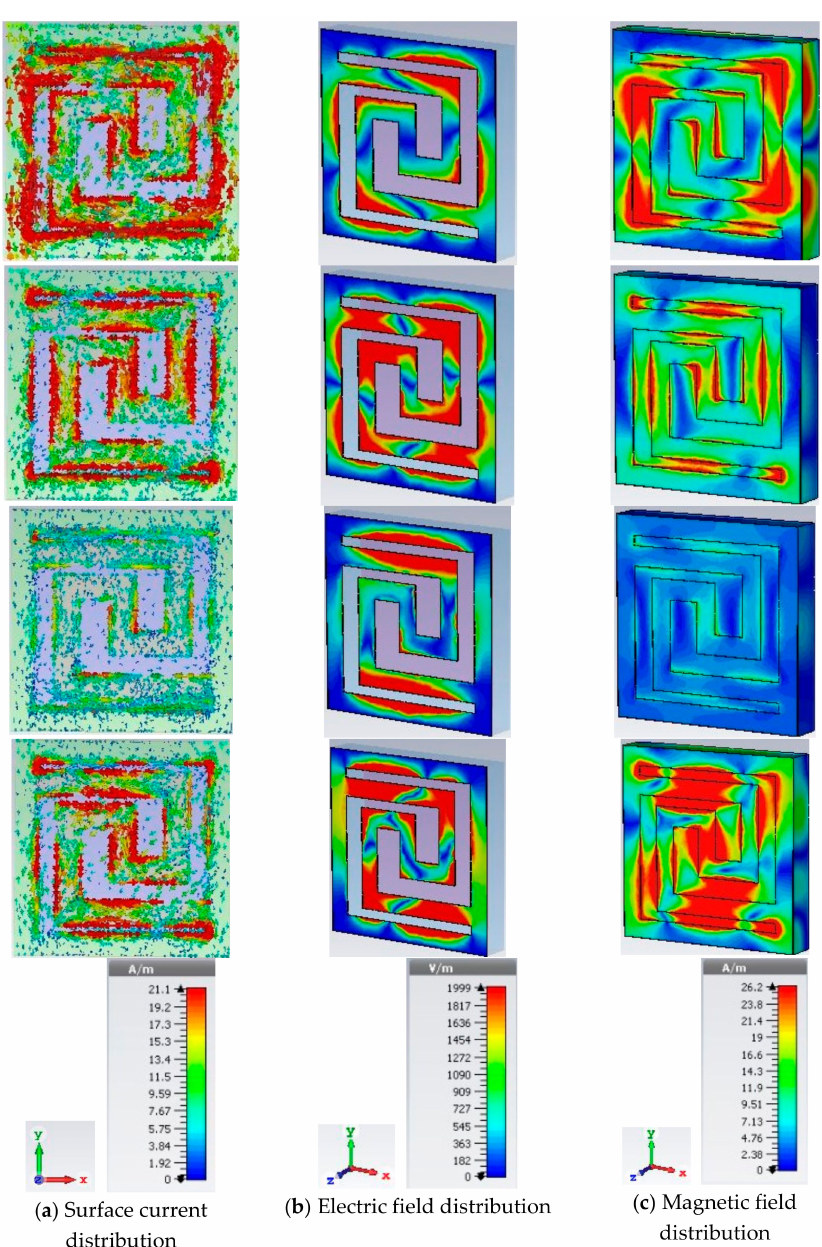
Figure 8. Instantaneous distribution of ( a ) surface current, ( b ) electric field, and ( c ) magnetic field at 15.3, 17.4, 20.06, and 21.3 GHz, respectively, for FR4 substrate. At 14.64 GHz, the electric field distribution shows intense resonance at the circumference of the resonator, but the magnetic field shows resonance on the places where electric fields were less intense. This is why permittivity becomes negative, but permeability became positive. Hence in this frequency, the unit cell acts as an SNG absorber. For the rest of the resonance frequencies, the electric and magnetic fields are intense at the same places of the resonator, and hence both permittivity and permeability are negative, resulting the unit cell to act as a DNG